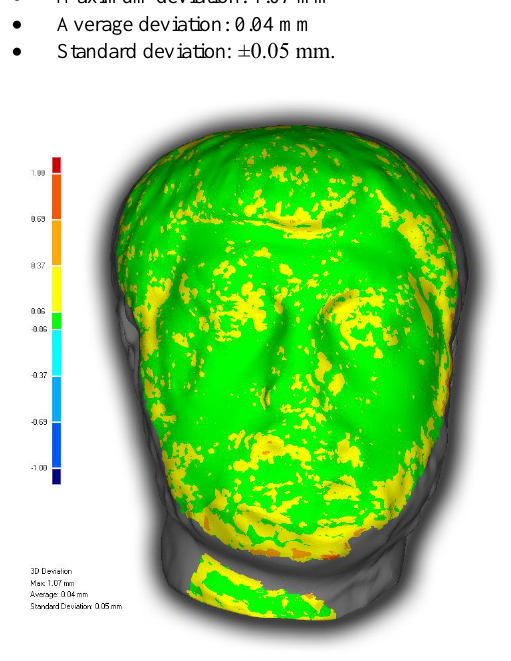
Figure 6. Graphical representation of spatial differences in